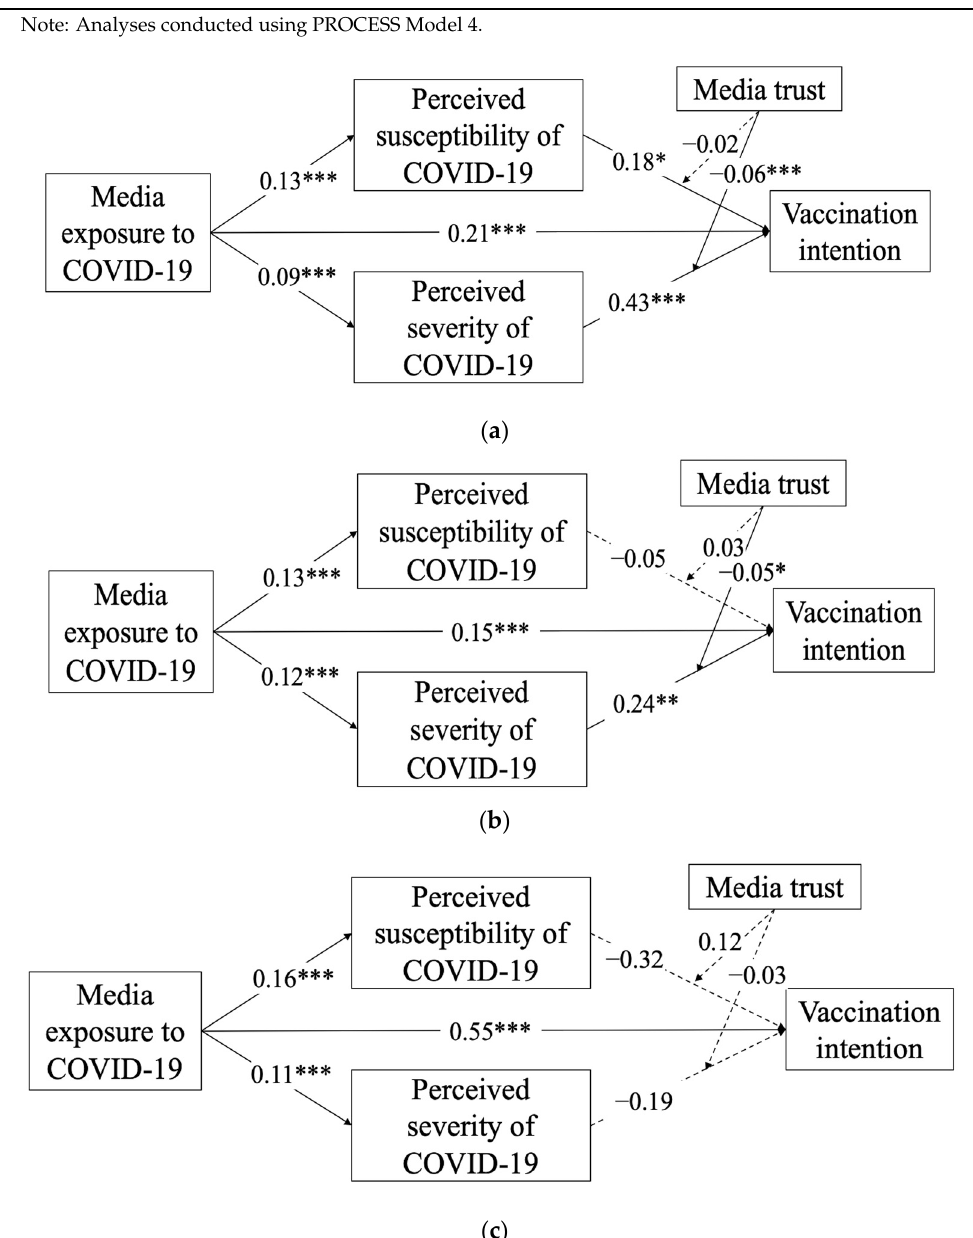
Figure 2. ( a ) Test of the model in Mainland China. ( b ) Test of the model in Taiwan. ( c ) Test of the model in Hong Kong. Note: Solid-line arrows are significant at p < 0.05 or higher. Dotted-line arrows are non-significant at p < 0.05. * p < 0.05; ** p < 0.01; *** p < 0.001.